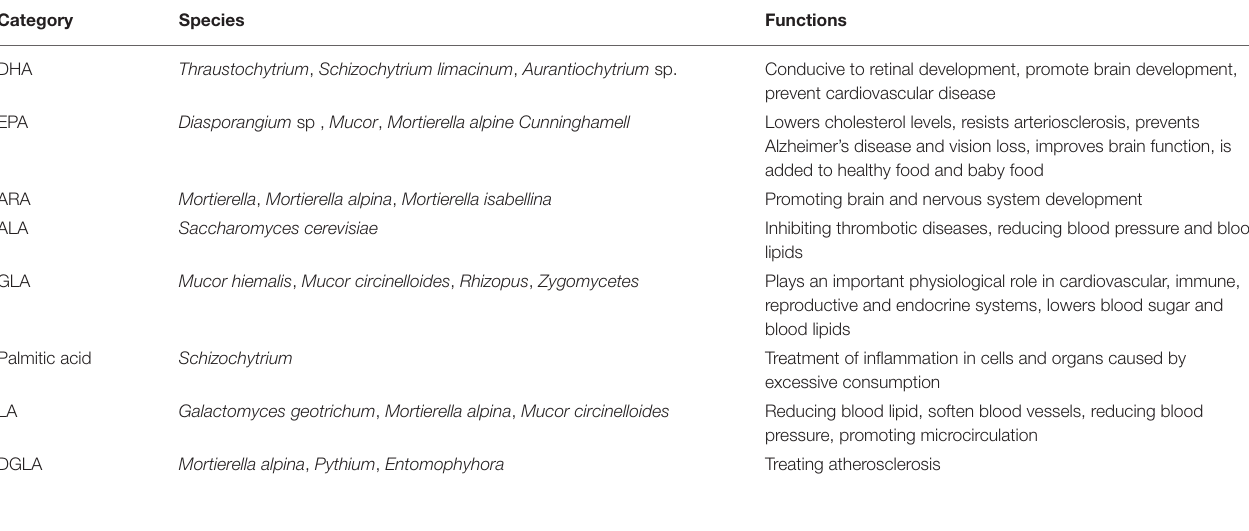
TABLE 4 | Sources and uses of various unsaturated fatty